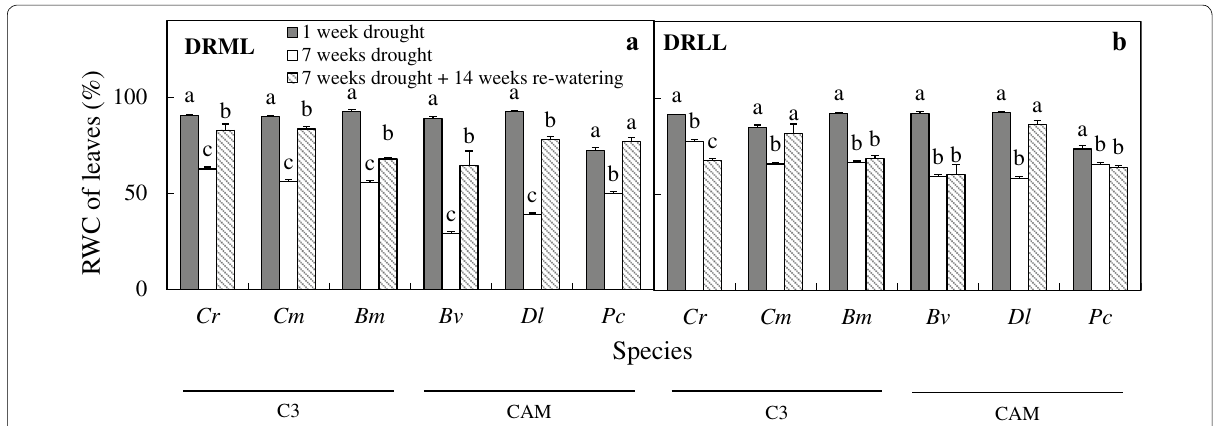
Fig. 5 RWC of leaves of C. rochussenii ( Cr ), C. mayeriana ( Cm ), B. membranaceum ( Bm ), B. vaginatum ( Bv ), D. leonis ( Dl ) and P. cornu - cervi ( Pc ) after 1 and 7 weeks of drought and after 14 weeks of re-watering under moderate light ( a ) and low light ( b ). Vertical bars represent standard error. Different letters above bars indicate statistical difference (Tukey’s multiple comparison, p < 0.05, n